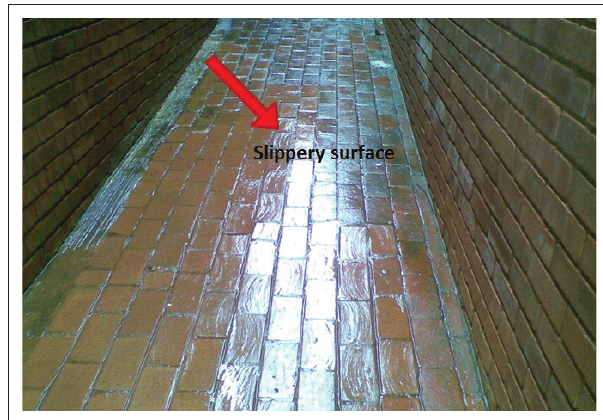
FIGURE 1: Algae growing on a building’s wall and